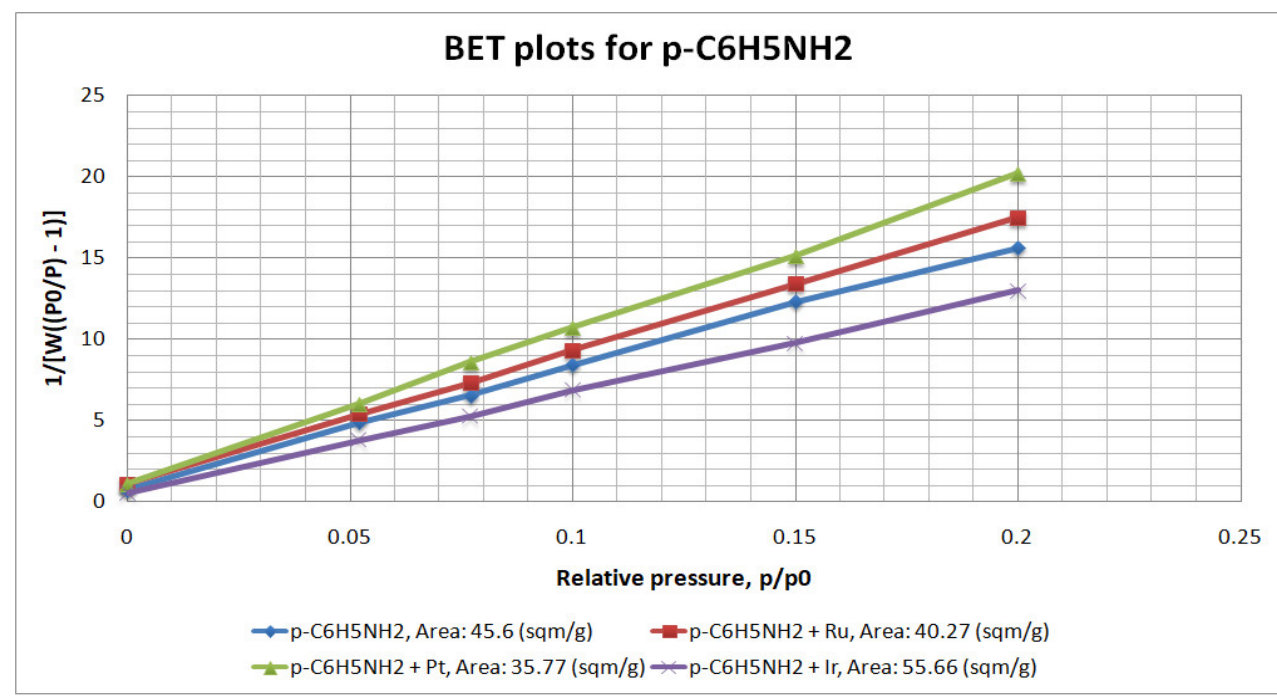
Figure 3. BET plots for the doped and undoped MW-CNTs.